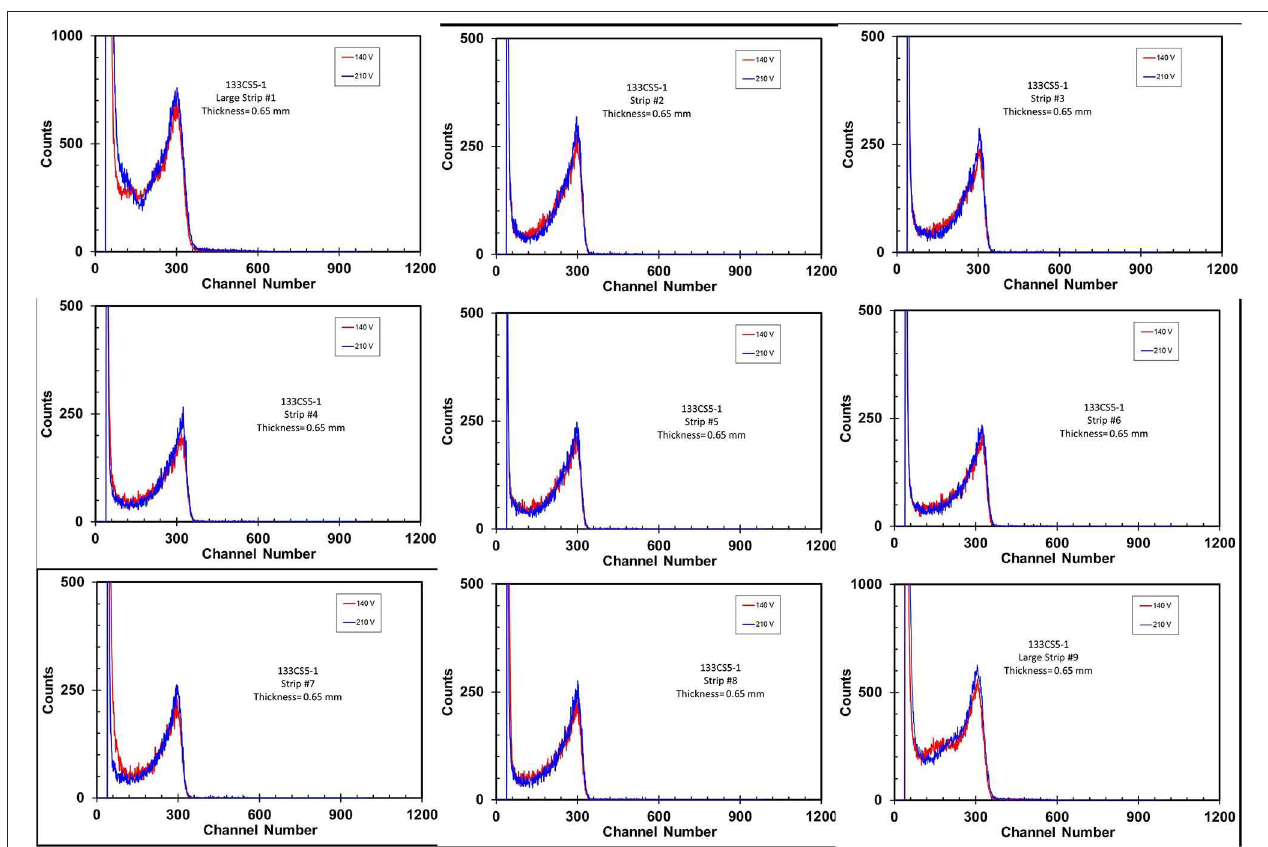
FIGURE 9 | Depth corrected 137 Cs spectrum from a single pixel of the 13mm thick array.